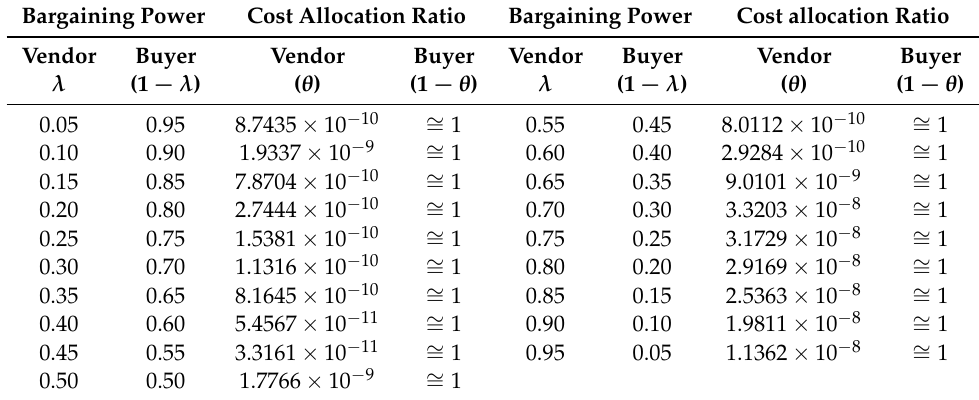
Table 5. Calculation of lead time crashing cost for vendor and buyer with respect to bargaining power. Bargaining Power Cost Allocation Ratio Bargaining Power Cost allocation Ratio Vendor